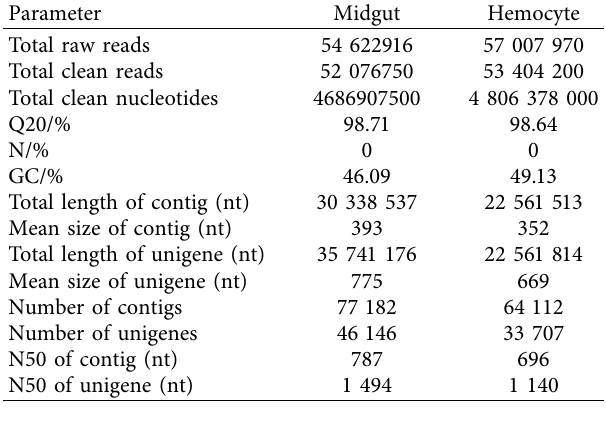
Figure 2: Size distribution of the lengths of Helicoverpa assulta hemocyte unigenes.